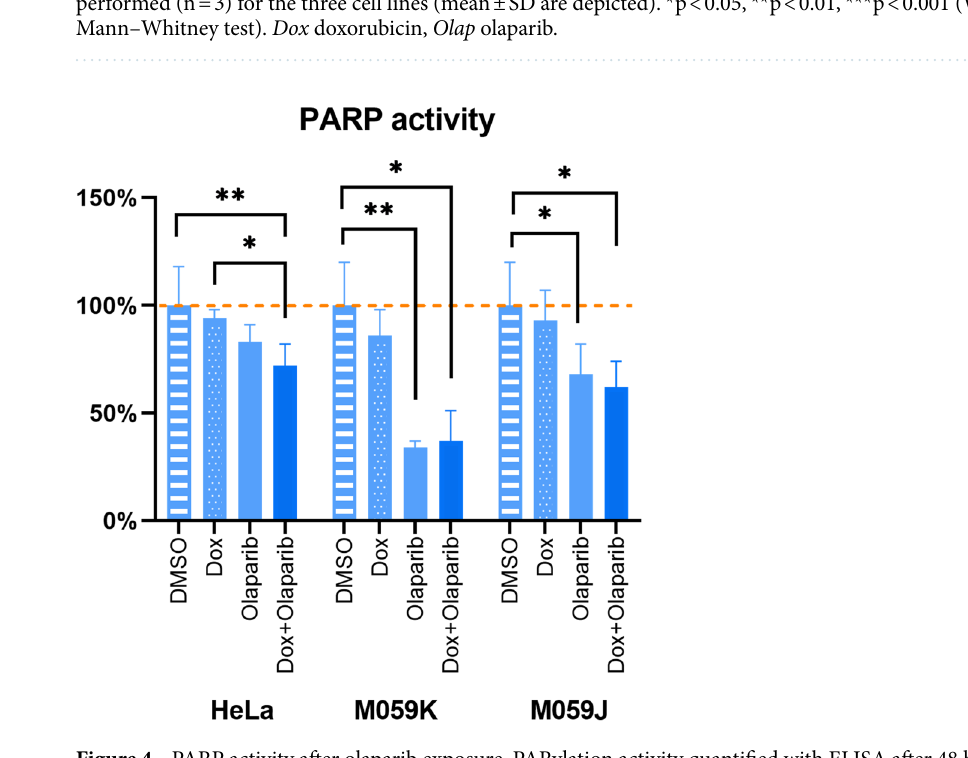
Figure 4. PARP activity after olaparib exposure. PARylation activity quantified with ELISA after 48 h of exposure to doxorubicin (IC 10 ) combined or not with olaparib (IC 50 ). Data are shown as a ratio to the control condition (DMSO only). Three independent experiments were performed (mean ± SD are depicted); *p < 0.05, **p < 0.01 (non-parametric Dunn test). Dox: